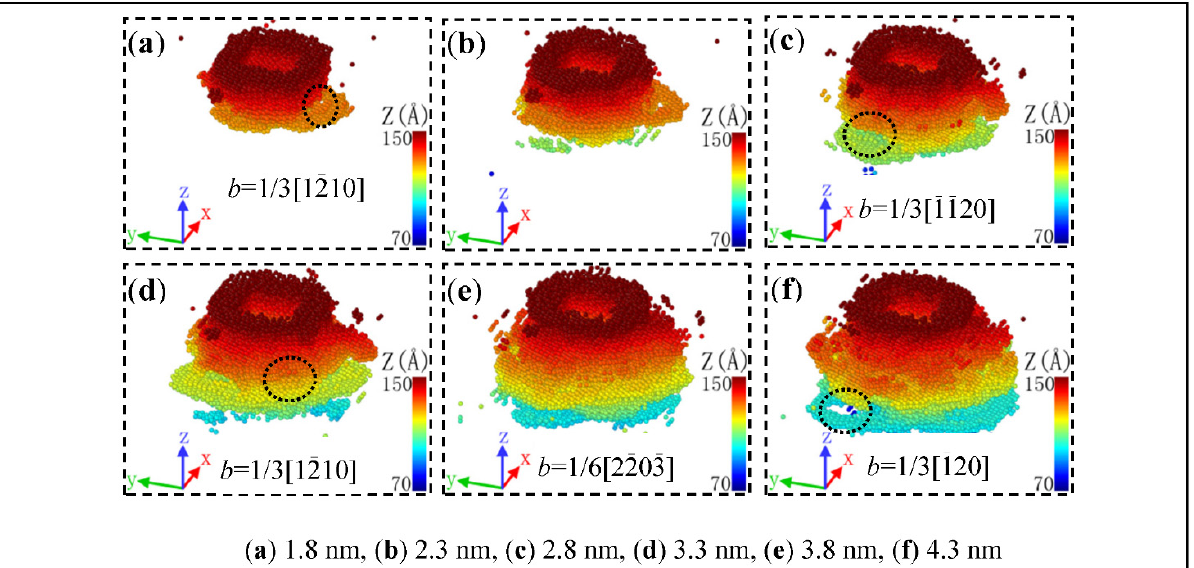
Figure 2. Deformation process of 6H-SiC (0001) crystal surface with different indentation